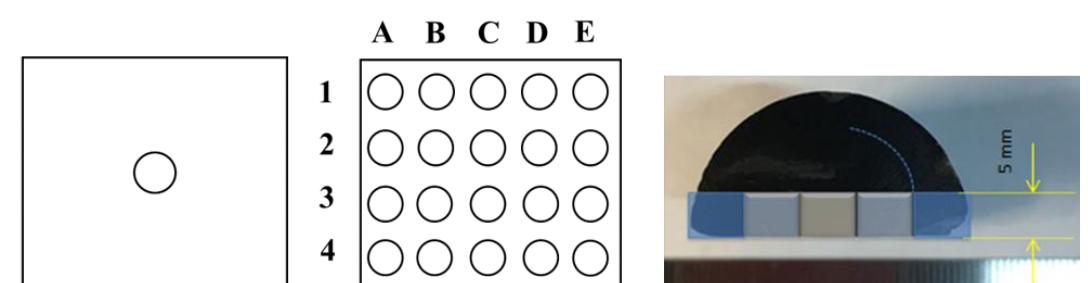
Figure A2. Photographs of the experimental units.